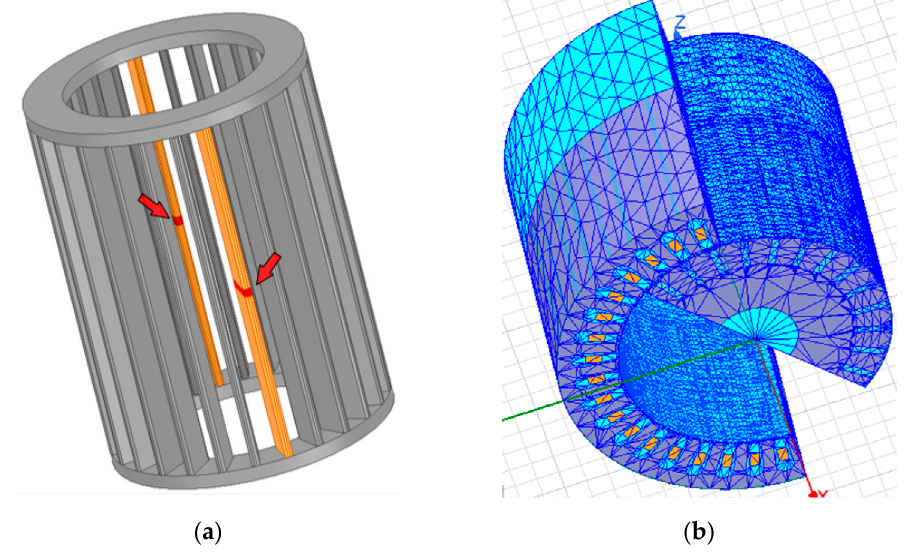
Figure 2. ( a ) Position and detail of broken bars in rotor cage; ( b ) finite element mesh.